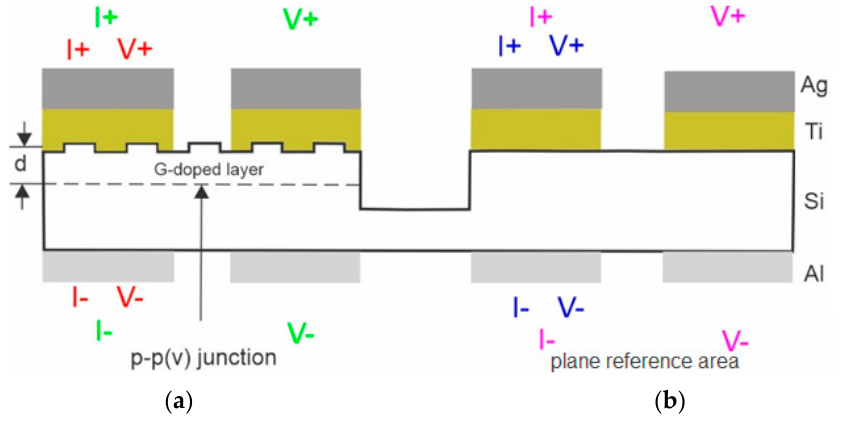
Figure 2. Cross-section of the prepared sample: ( a ) representing p-p(v)-M junction and ( b ) repre- senting reference junction. The I- and V- labels represent the location of the 2-probe and 4-probe